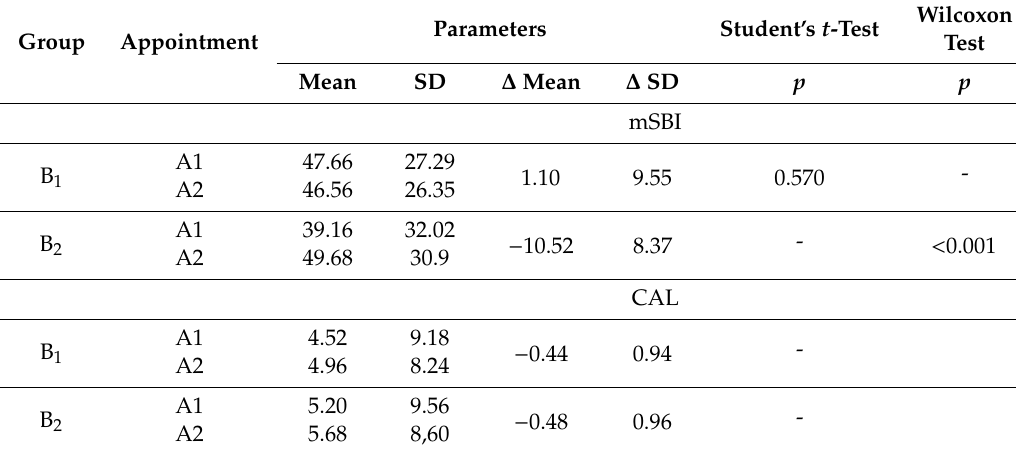
Table 4. Results of Student’s t -test and Wilcoxon test for mSBI and CAL